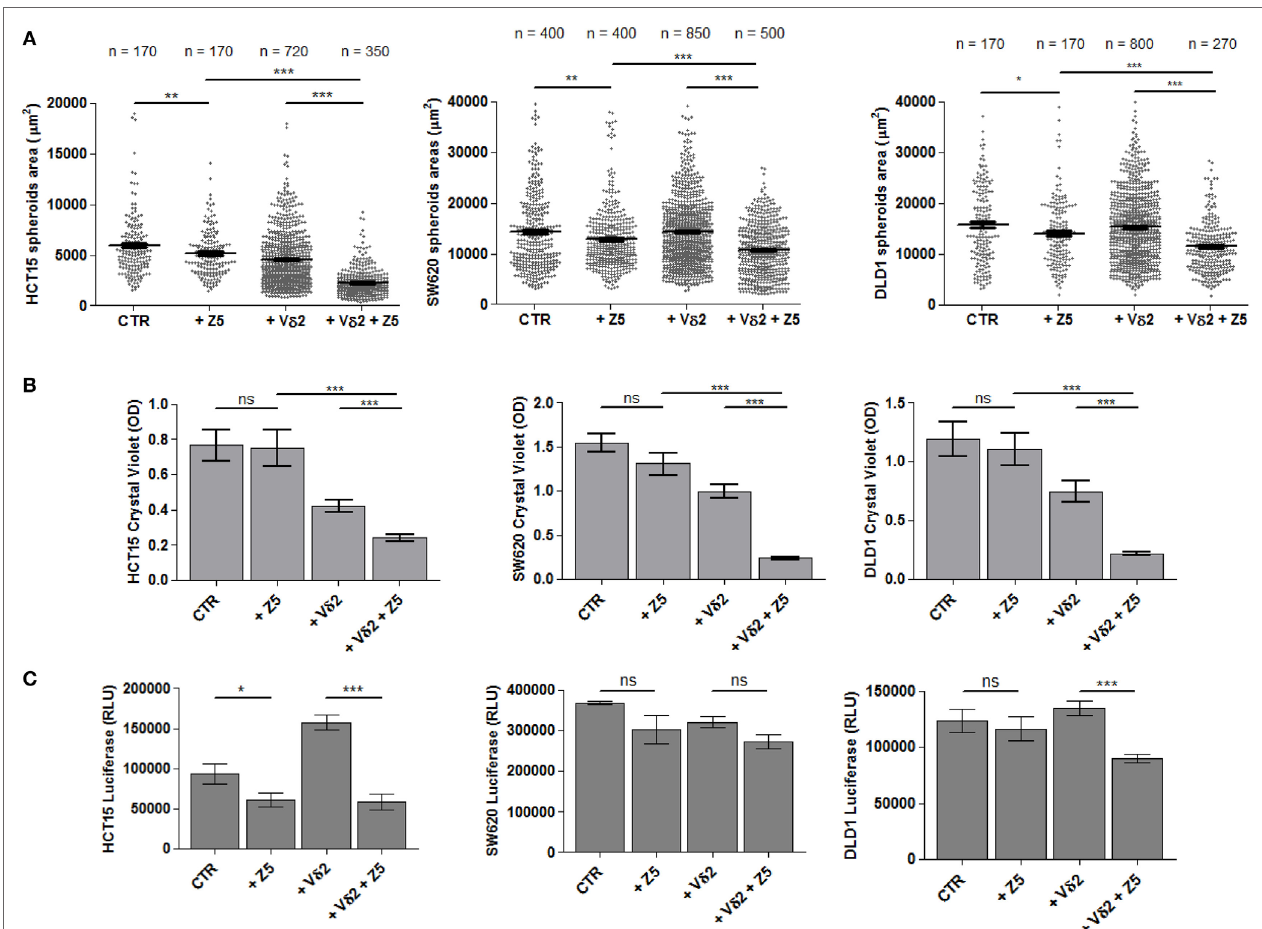
FIGURe 5 | Effect of Zol and V δ 2 T cell populations on CRC spheroid size and viability. (A) Spheroids from different CRC cell lines (HCT15, left; SW620, middle; and DLD1, right) were generated in serum free medium supplemented with epithelial growth factor (10 ng/ml). On day 6, culture wells were incubated for additional 24 h without (CTR) or with 5 µM Zol ( + Z5) or V δ 2 T cells ( + V δ 2) or V δ 2 T cells + 5 µM Zol ( + V δ 2 + Z5). Then, each culture well was analyzed for the measurement of spheroids. The number of spheroids analyzed is indicated in the upper part of each plot; data are from experiments performed with six different V δ 2 T cell populations in triplicate wells for each donor. Each symbol in the plot indicates a single spheroid. Bars: mean ± SEM of that group of measures. * p < 0.01; ** p < 0.001; *** p < 0.0001. (B) Cells from the different cultures defined in panel (A) , were gently harvested and transferred to conventional 96-well flat-bottomed plates to allow the adhesion of CRC epithelial cells. After 48 h, cell cultures were labeled with crystal violet followed by extensive washes (to remove non-adherent cells) and lysis of adherent cells. Optical density (OD) at 595 nm was evaluated with a VICTORX5 analyzer. Bars: mean ± SD of three experiments. *** p < 0.0001; ns, not significant. (C) Cell cultures obtained as indicated in panel (A) were analyzed for ATP content with luciferase assay. Data are shown as luminescence in relative light units (RLU) arbitrary units determined with a VICTORX5 analyzer. Bars: mean ± SD of three